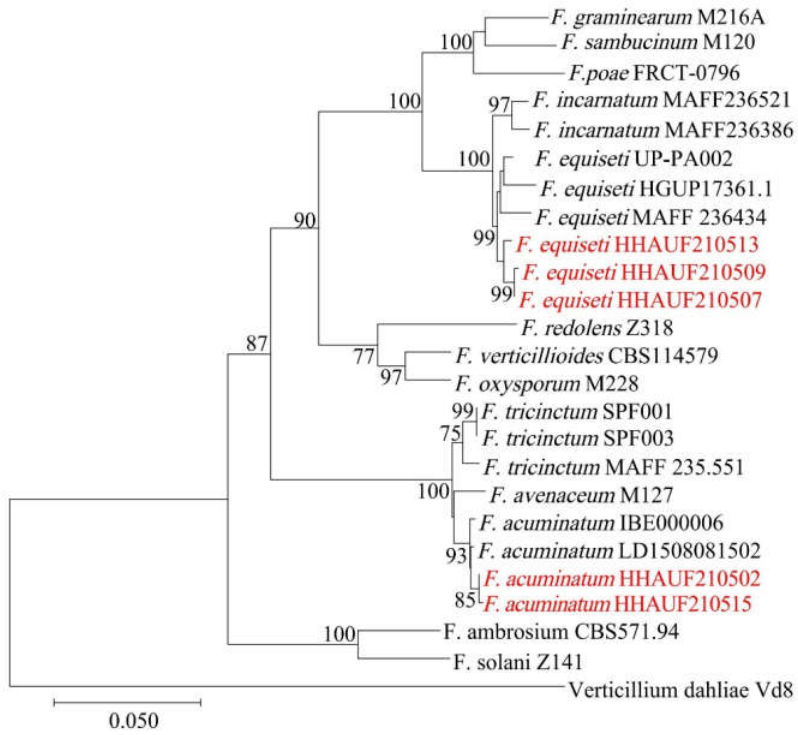
Figure 3. Phylogenetic tree inferred from concatenated ITS, Tub , and EF1-α sequences using the neighbor-joining method. Bootstrap values (%) presented at the branches were calculated from 1000 replications. Values below 50% are hidden. The scale bar indicates a 5% sequence difference.